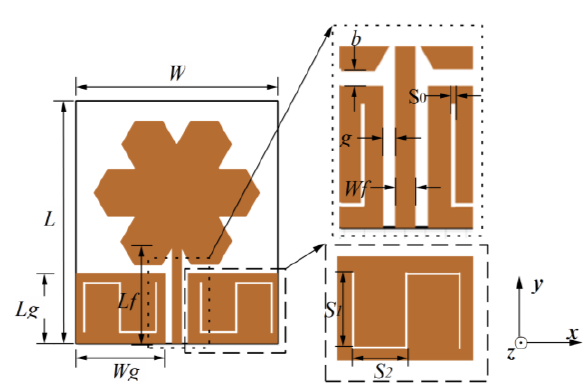
Figure 3: Geometry of the proposed structure.